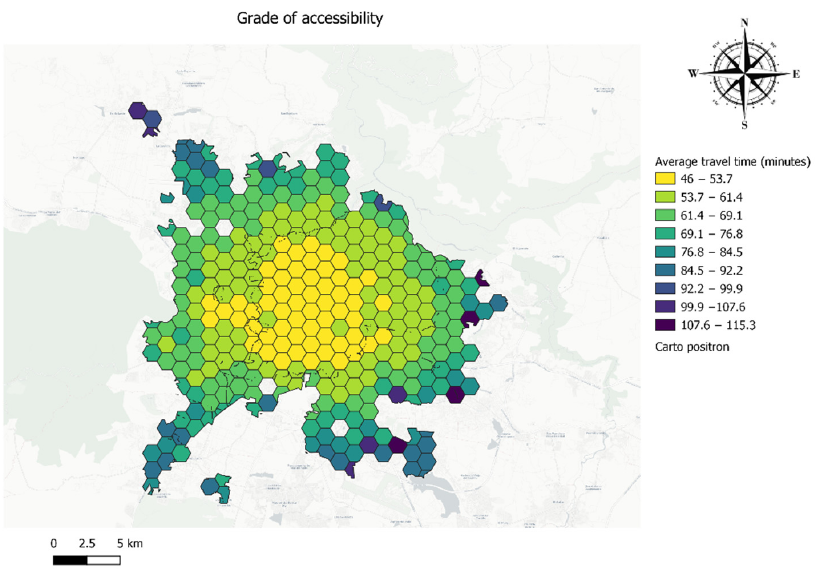
Figure 7. Grade of accessibility.